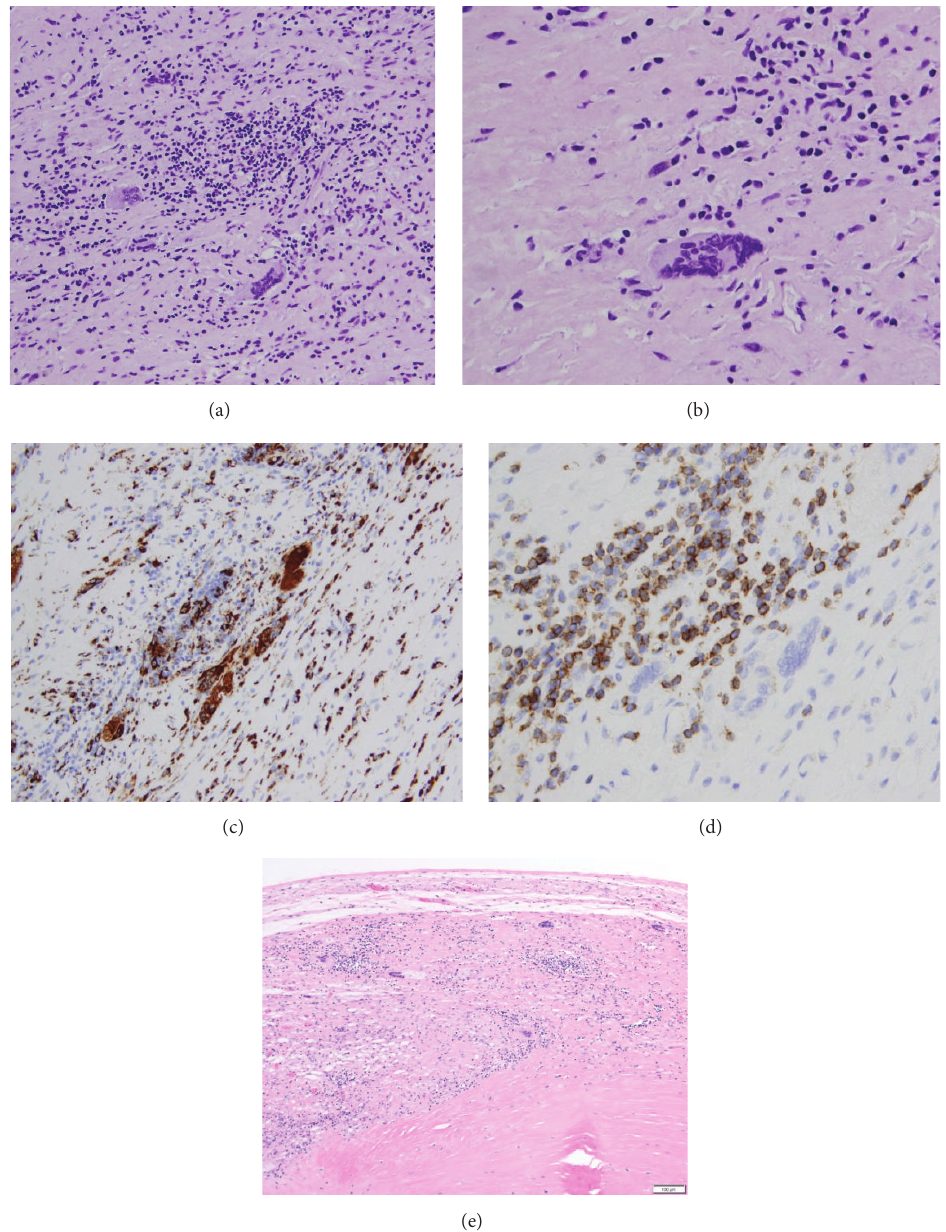
Figure 2: Histopathology of giant cell myocarditis. (a) Myocardium with prominent lymphohistiocytic infiltrate and well-formed multinucleated giant cells (H&E, original magnification × 200). (b) High power magnification (H&E, original magnification × 400) showing extensive myocardial damage by a dense inflammatory infiltrate. (c) Histiocytic infiltrate (CD68-PGM-1, original magnification × 200). (d) The lymphocytic infiltrate consists primarily of T-lymphocytes (CD3, original magnification × 400). (e) Atrioventricular node involved by giant cell myocarditis (H&E, original magnification, ×